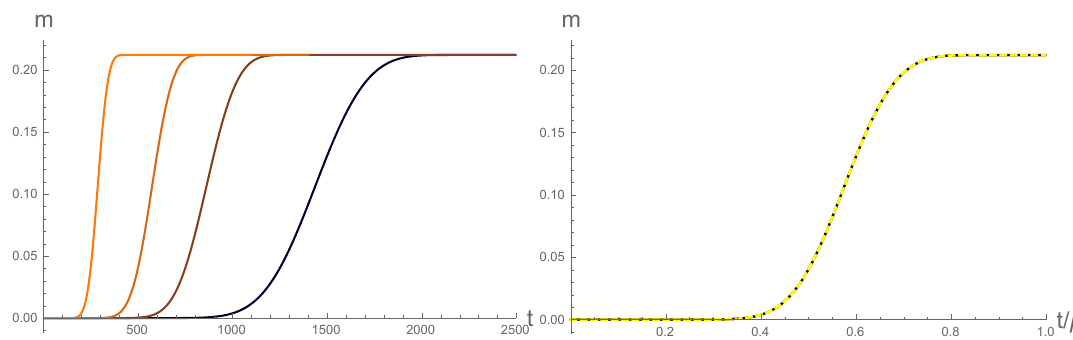
Figure 11 . Left: m ( t ) for quenches of the form (3.1) to the harmonic driving (cid:15) = 0 : 09 ; ! b = 2. From left to right, (cid:12) = 500 ; 1000 ; 1500 ; 2500. Right: m ( t=(cid:12) ) for the quenches of the right (cid:12)gure. The curves clearly collapse into a universal pro(cid:12)le (dotted black). We also plot m SPS ( (cid:26) b ( t=(cid:12) ) ; ! b ) in (solid) yellow. The agreement between both curves implies that the system responds